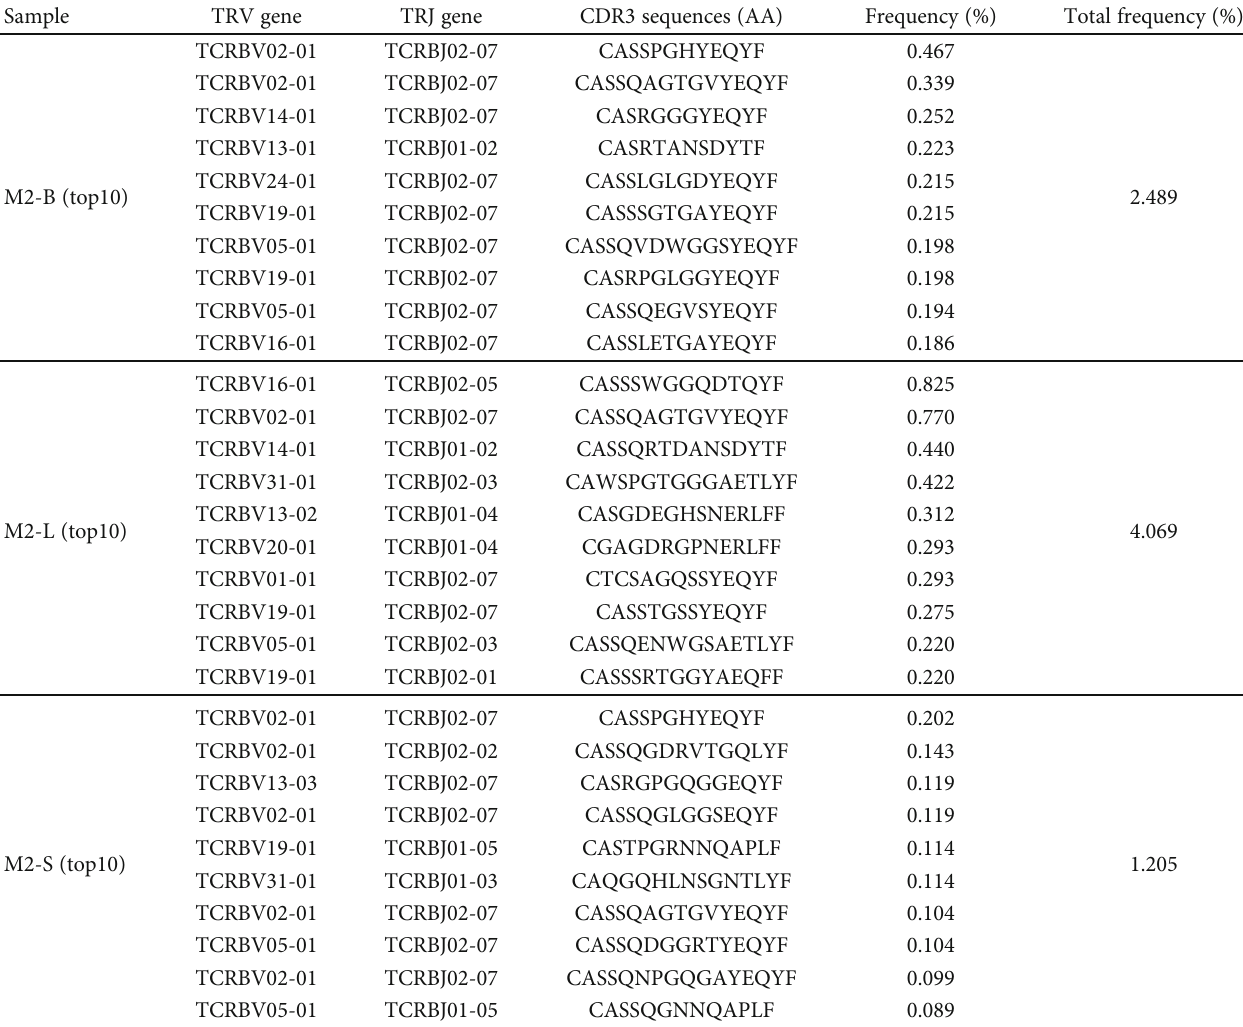
Table 6: Analysis of composition and characteristics of frequency for the top ten sequences and the usage of TBBV and TRBJ gene, CDR3 AA of CD4 + CD25 + T cells TCR β CDR3 repertoires in breast tumor tissues, lung metastatic tissues, and spleens from 4T1 tumor-bearing BALB/c mouse